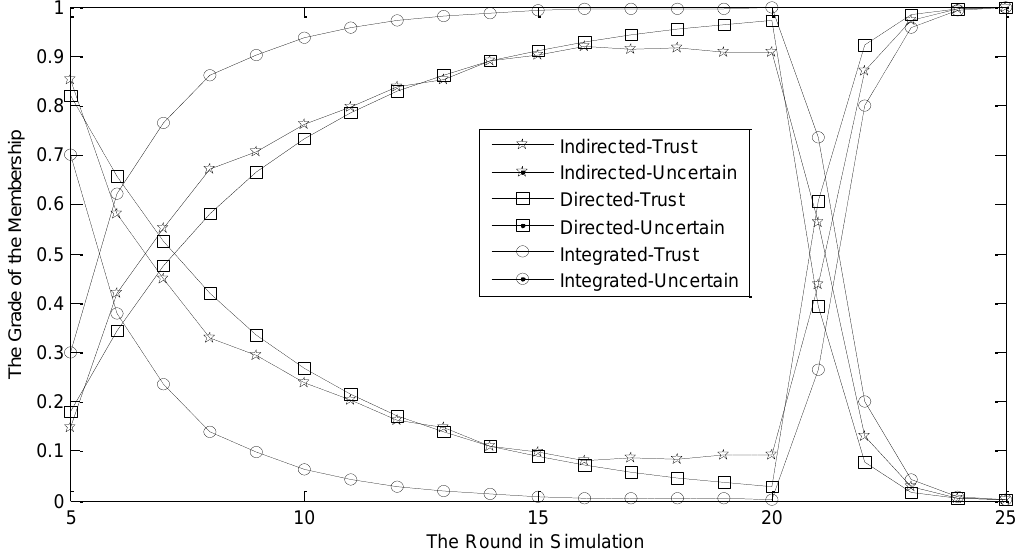
Figure 4. The membership grade of the distrustful